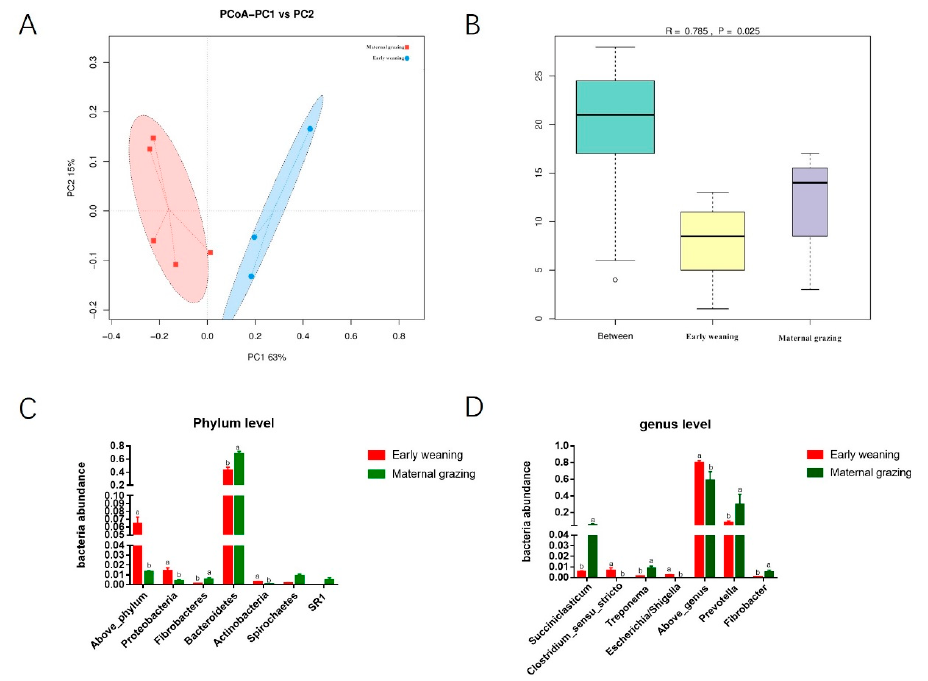
Figure 1. Ruminal microbial community di ff erence between the di ff erent feeding paradigm groups (n = 4). ( A ) PCoA analysis. ( B ) Anosium analysis. ( C ) Di ff erential ruminal microbes at phylum level based on t -test analysis. ( D ) Di ff erential ruminal genera based on t -test analysis.